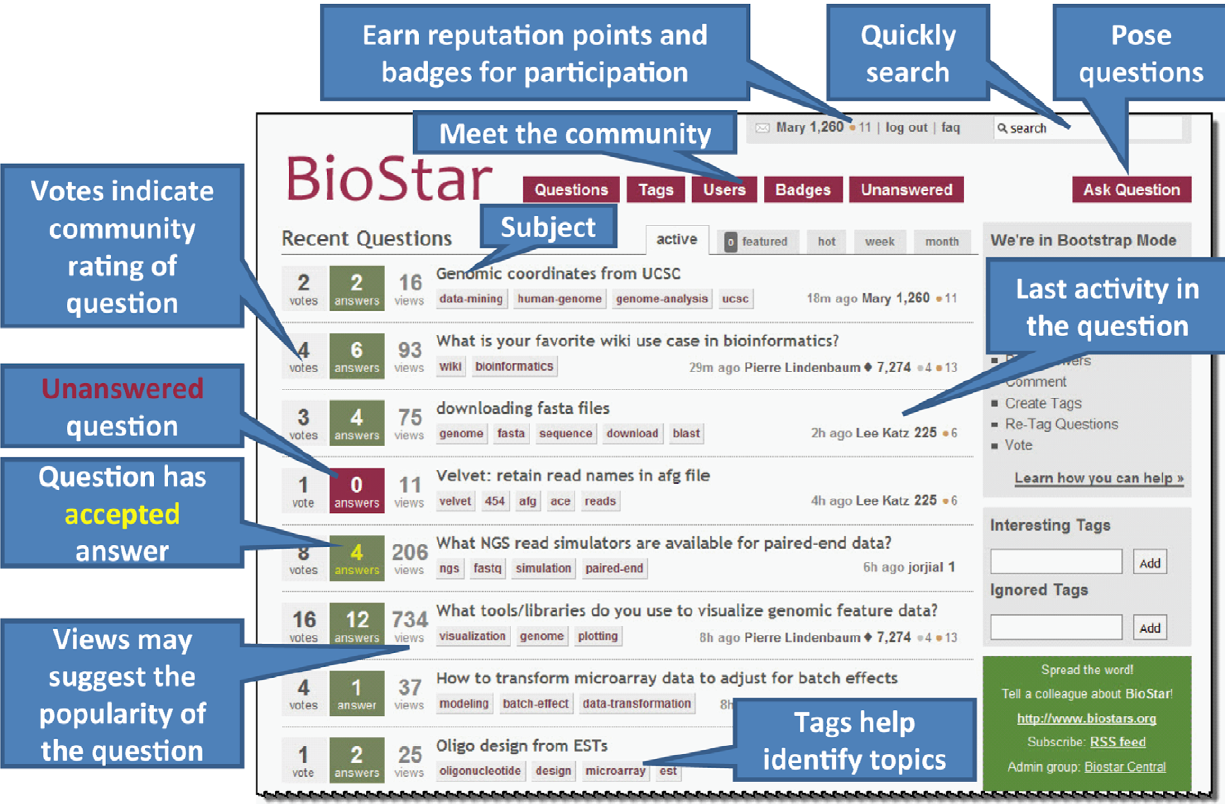
Figure 1. BioStar offers the opportunity to ask and answer a wide range of bioinformatics-related questions. Community members pose and answer queries on many topics. Questions and answers can be voted upon by members such that reputation points and badges are earned and help to assess the level of community respect and engagement. ‘‘Views’’ values can help assess the popularity of a question. Searches and tags enable users to quickly locate topics of interest.